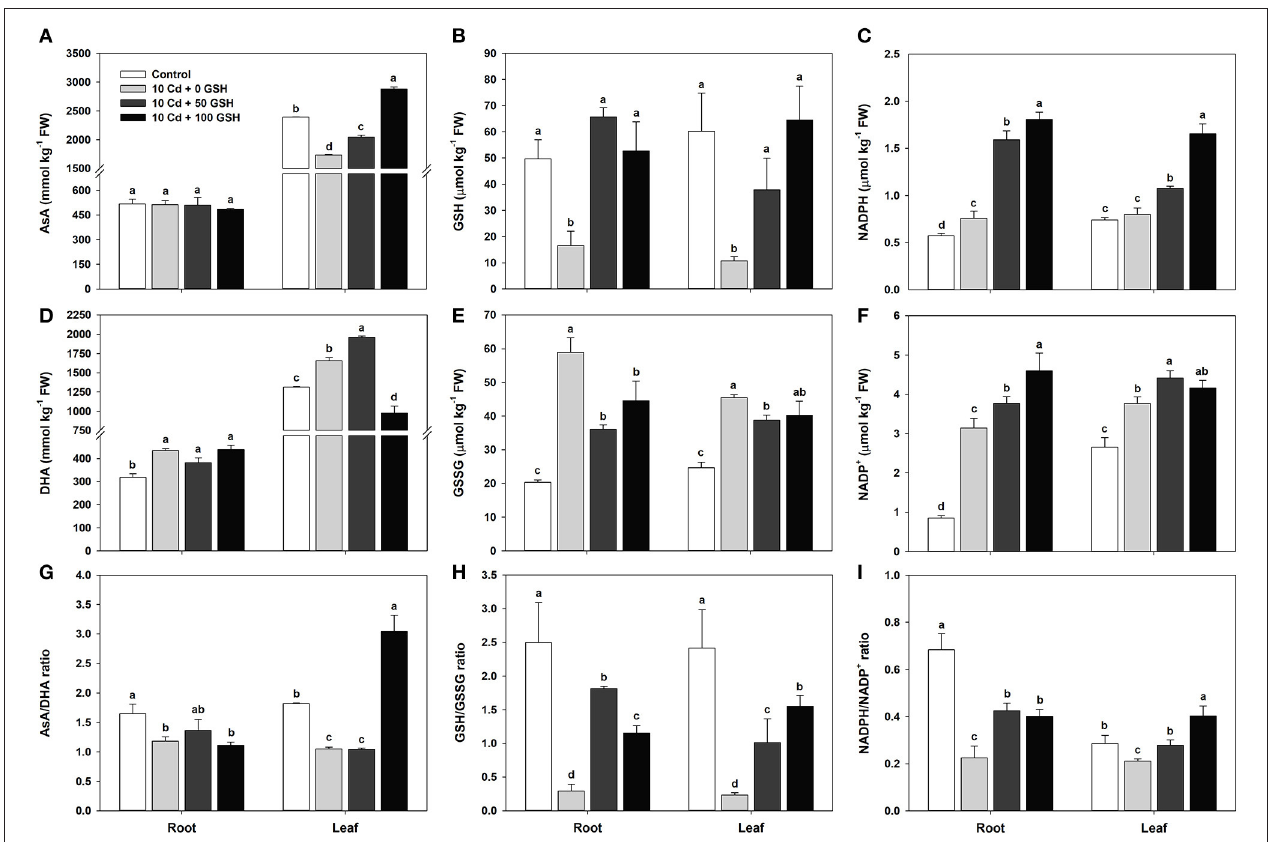
FIGURE 3 | Ascorbate (AsA, reduced form)/GSH (reduced form)/nicotinamide adenine dinucleotide phosphate (NADPH, reduced form); dehydroascorbate (DHA, oxidized form)/GSH disulfide (GSSG, oxidized form)/nicotinamide adenine dinucleotide (NADP + , oxidized form) concentration; the AsA/GSH/NADPH redox ratio in the roots and leaves of oilseed rape plants grown under control (no Cd or GSH) or 10 µ M Cd stress conditions sprayed with/without GSH (0, 50, and 100mg kg − 1 ). Measurements were made 10 days after treatment. Concentrations of (A–C) AsA, GSH, and NADPH; concentrations of (D–F) DHA, GSSG, and NADP + ; (G–I) AsA, GSH, and NADPH redox ratios. Data are presented as mean ± SD ( n = 3). Means denoted by the same letter are not significantly different at the P < 0.05 level according to Fisher’s least significant difference (LSD)